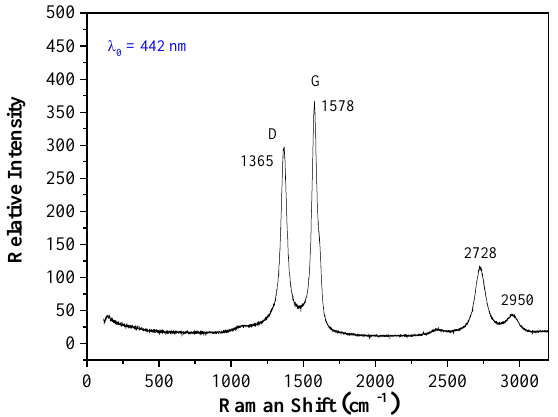
Figure 1. Raman spectrum of Thin-MWCNT-COOH buckypaper.